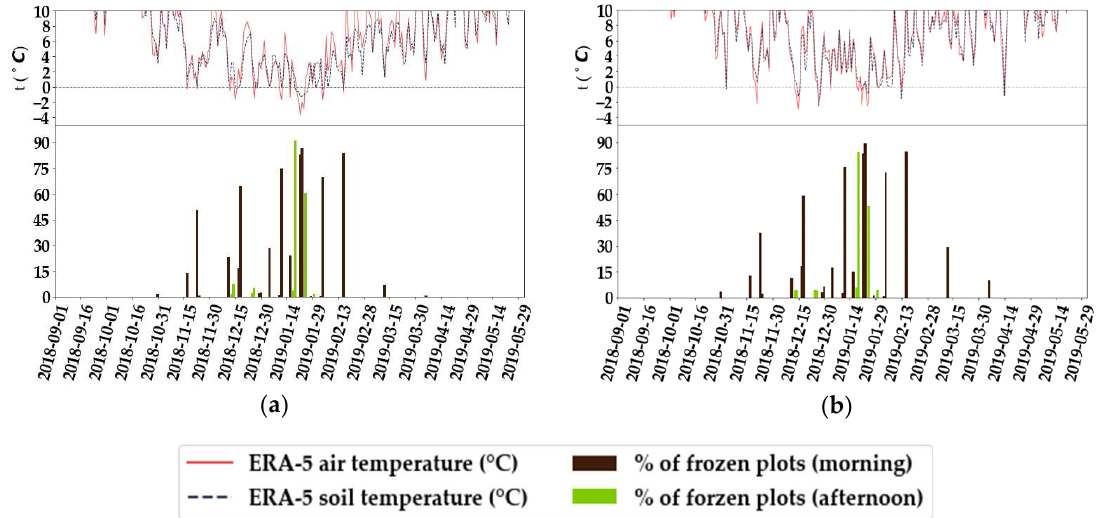
Figure 14. The distribution of frozen plots in site B in comparison to ERA5-Land’s soil and air temperatures, for each S1 acquisition, and using VH ( a ) and VV ( b ) polarizations after applying the temperature filter. ( a ) VH, and ( b ) VV.